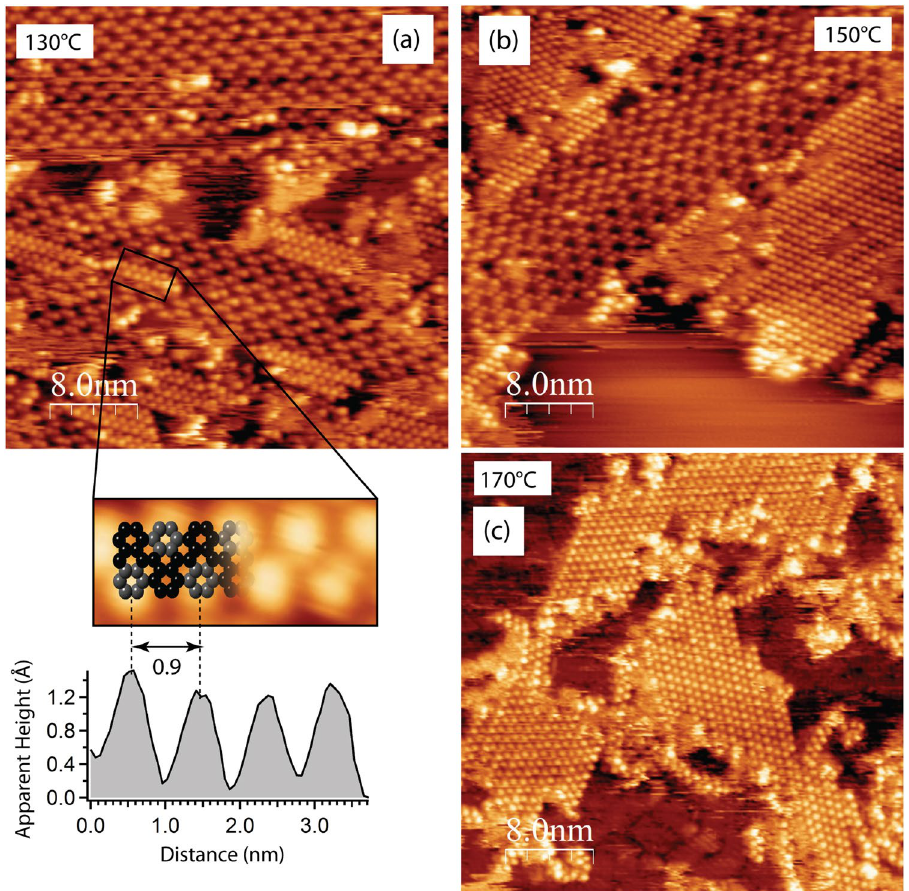
Figure 4. ( a – c ) STM images of OM chains on Ag(111) surface annealed for 30 min at the indicated temperatures. This set of STM images illustrates the transformation of OM chains into covalent ones. An enlarged region of the area indicated by the black rectangle is shown under ( a ). The height profile is taken along the chain axis and shows a periodicity of 0.9 nm characteristic for the polyanthracene chain, whose ball and stick model is overlaid on top. Grey colored carbon atoms show the lobes of the anthracene subunits pointing upward. Tunneling parameters (VS/IT): ( a ) + 1.5 V/300 pA; ( b ) + 1.7 V/100 pA; ( c ) + 1.7 V/150